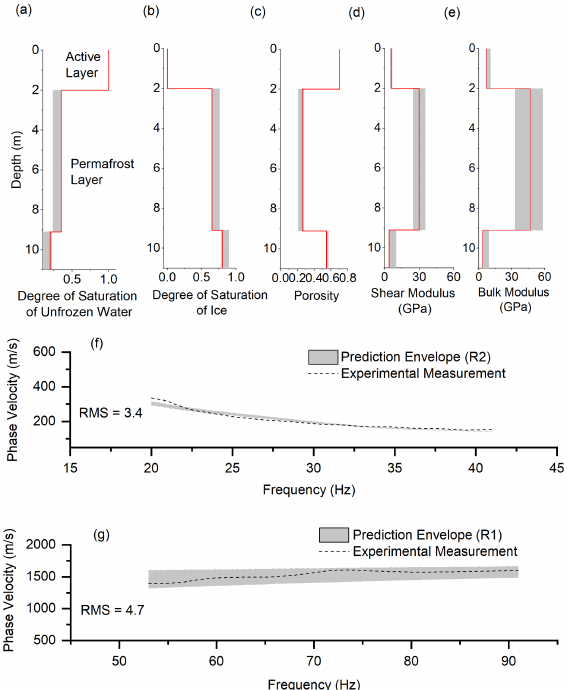
Figure B2. Surface wave inversion results for section 3: 240 to 360m. (a) Degree of saturation of unfrozen water, (b) degree of saturation of ice, (c) porosity distribution, (d) shear modulus of solid skeletal frame, (e) bulk modulus of solid skeletal frame, (f) experimental and numerical dispersion curves for the R2 wave, and (g) experimental and numerical dispersion curves for the R1 wave.